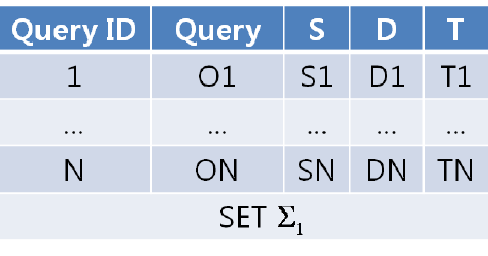
Figure 5. Example of a query set sent from the BS to a